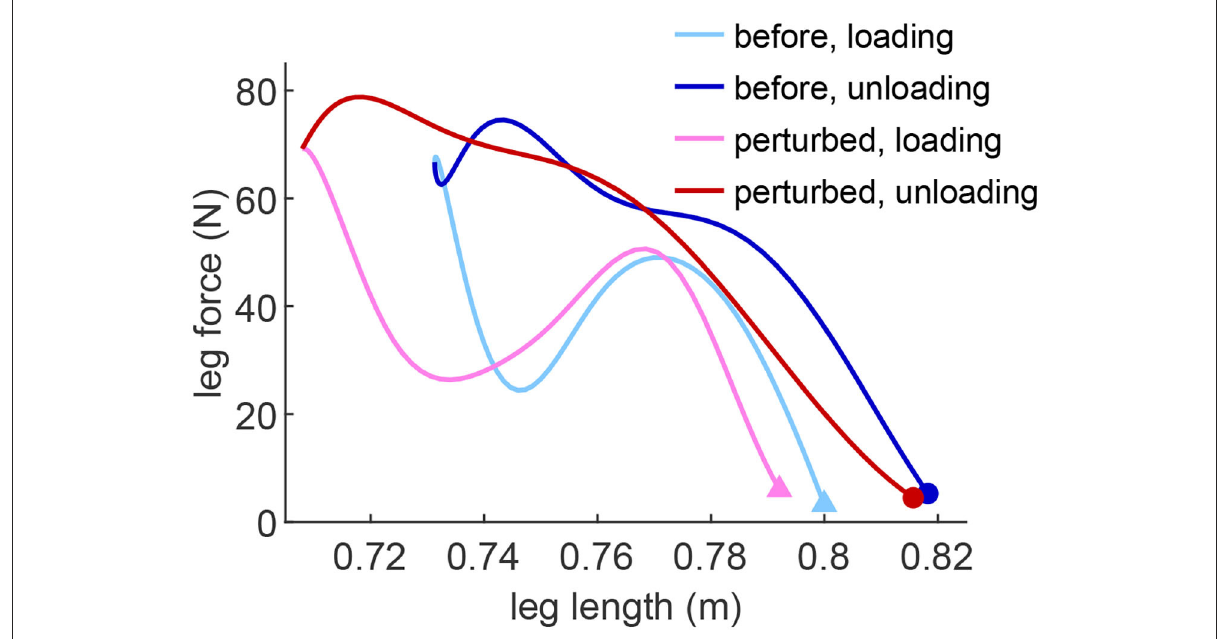
FIGURE4 Example of the leg force-length curve of the perturbed hop (in red) and the stable hop (in blue) before the perturbation ( P se = 0.4MPa, P ext = 0.5MPa, P fle = 0.6MPa). The leg force-length curve is divided into the loading phase (the CoM moving downwards during the stance phase) and the unloading phase (the CoM moving upwards during the stance phase). The triangle and the dot markers denote the touch-down and take-off, respectively.